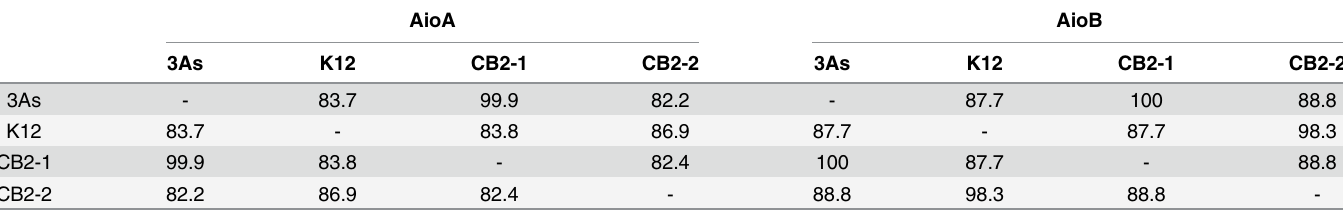
Fig 3. Synteny of the aio loci of the Thiomonas spp. isolates. The top portion represents the RGP19-like region present in each genomes and the bottom portion represents the RGP10-like region. The % of nucleotide identity is expressed along a grey scale. The genes involved in the arsenic oxidation are localized on the aio operon (red). The aioX (orange), aioR (brown) and aioS (yellow) code for proteins involved in regulation and expression of aioBA . The cytochrome genes (green) are likely involved in electron transfer. The moaA gene (dark blue) is involved in the biosynthesis of molybdopterin, an essential co-factor for the catalytic activity of the protein. Black arrow represents CDS with no known function. Figures were generated with Easyfig [50]. doi:10.1371/journal.pone.0139011.g003 Table 1. Percent of identity between AioA and AioB of CB2, 3As and K12. Whereas both 3As and K12 encoded a single copy of AioA and AioB, CB2 encoded two copies of each protein, one in RGP19 and another in RGP10. AioA and AioB of CB2 encoded in the RGP19 shared more identity with AioA and AioB of 3As (99.9% and 100% respectively). However, AioA and AioB encoded on the RGP10 share more identity with AioA and AioB of K12 (86.9% and 98.3%